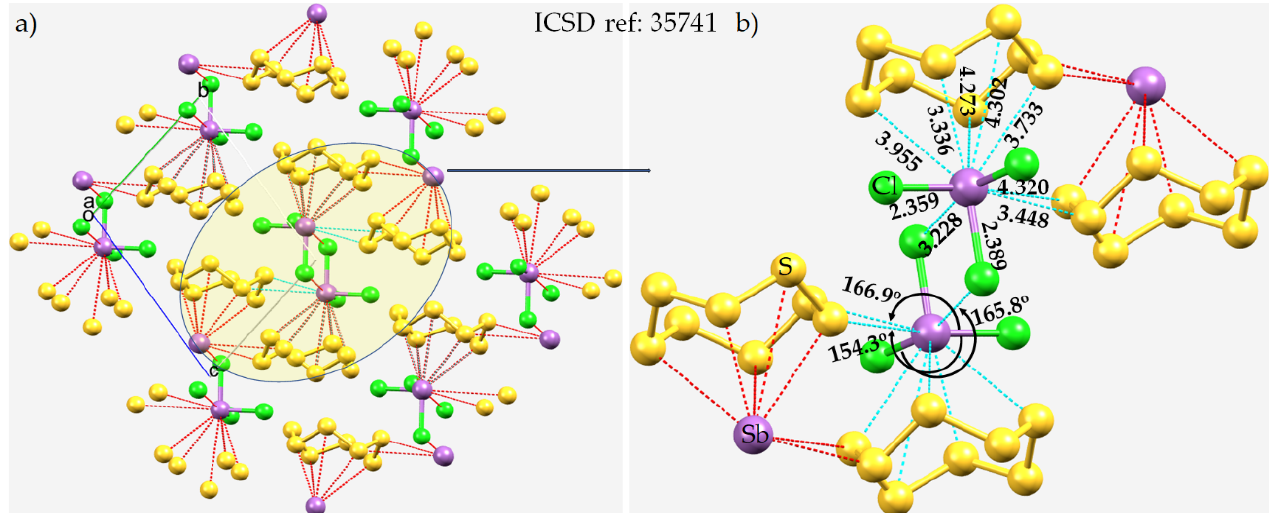
Figure 7. ( a ) The 2 × 2 extended crystal structure of the adduct SbCl 3 .S 8 . Hanging contacts are shown by dotted lines in red. The portion of the crystal in ( a ) encircled by an ellipse is shown in ( b ). Bond lengths and bond angles are in Å and degrees, respectively. Not all the Cl···S halogen bound and the S···Cl chalcogen bound contacts are shown. Atom type is marked in ( b ). The long arrow in black refers to the cluster that is encircled in ( a ).